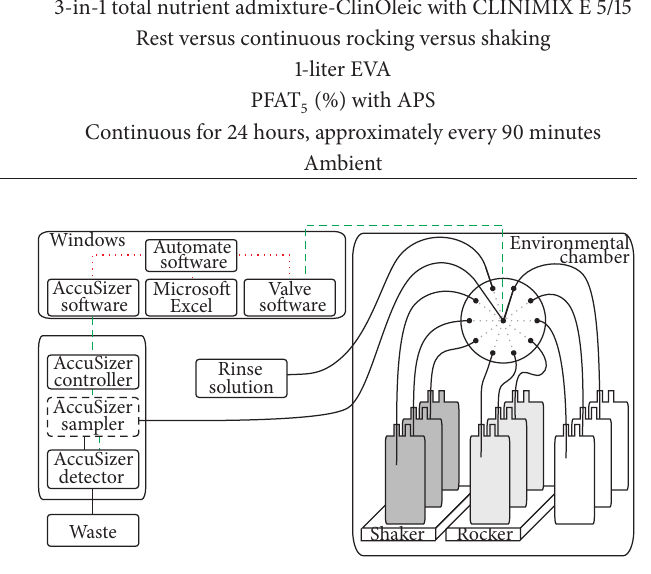
Figure 1: A schematic of the automated system is shown. The narrowly spaced red dashed lines represent the Automate software control of key Windows applications. The dashed green line repre- sents the electronic control of instrumentation, and the solid black lines represent fluid paths. The thick solid lines represent the fluid path of the test samples from a single sample container through the 10-port valve to the AccuSizer system and then finally to